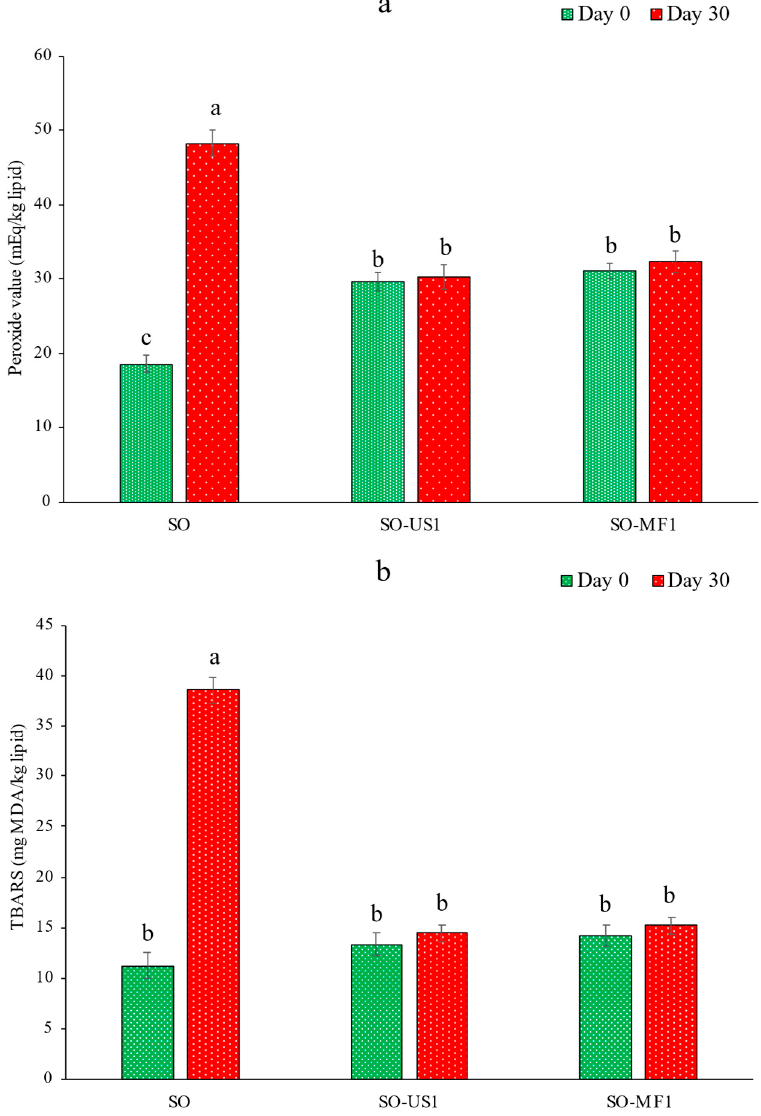
Figure 3. Peroxide (a) and TBARS values (b) for SO, SO-US1 and SO-MF1 at day 0 and day 30 of storage at room temperature (28 – 30 °C). Bars represent the standard deviation (n = 3). Different lowercase letters on the bars denote significant difference (p < 0.05). SO, shrimp oil; SO-US1, shrimp oil extracted from ultrasonicated KBPI-KC-SO microcapsules containing 0.1% SO; SO-MF1, shrimp oil extracted from microfluidized KBPI-KC-SO microcapsules containing 0.1% SO.